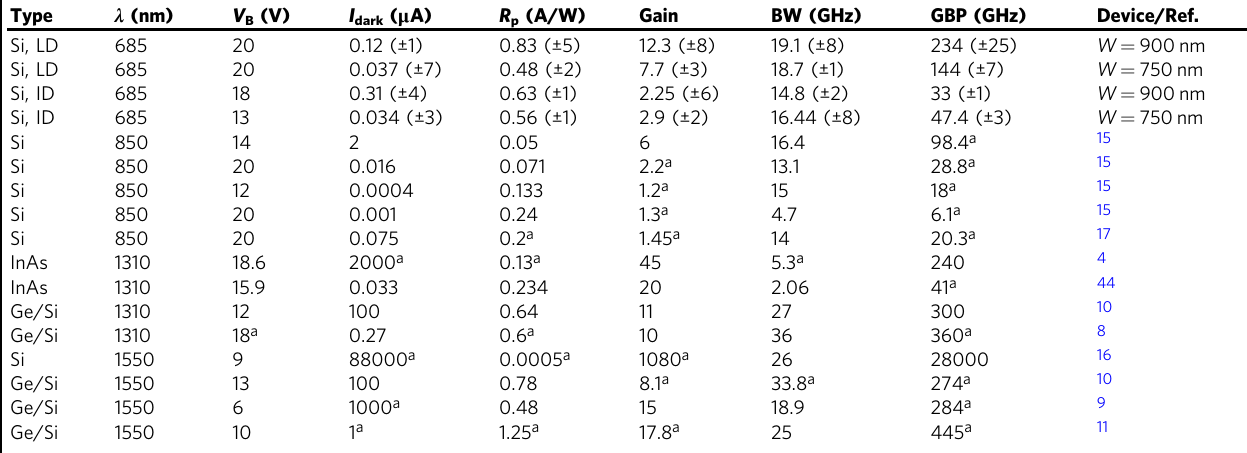
Table 1 Benchmarking of device performance with other recent reports of integrated APDs. Results from this work are listed in the top